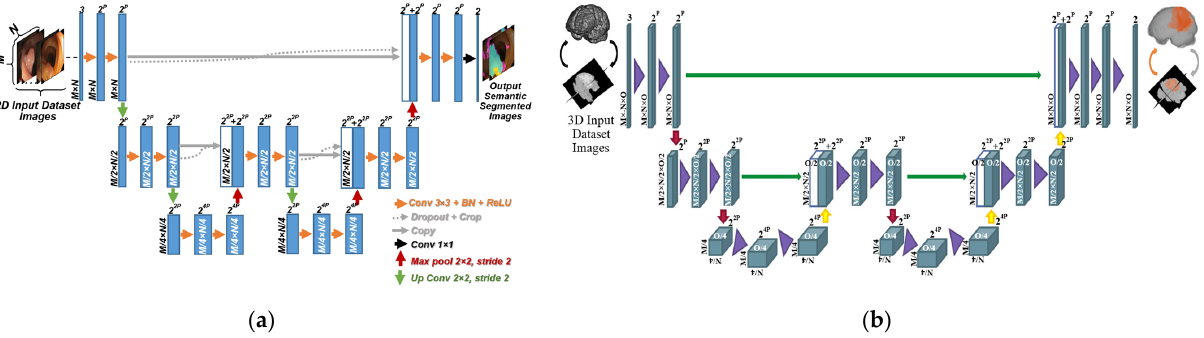
Figure 3. ( a ) Two ‐ dimensional AID ‐ U ‐ Net architecture with Direct path depth 2 and sub ‐ path depth 1; ( b ) three ‐ dimensional AID ‐ U ‐ Net architecture with direct path of depth 2 and sub ‐ path of